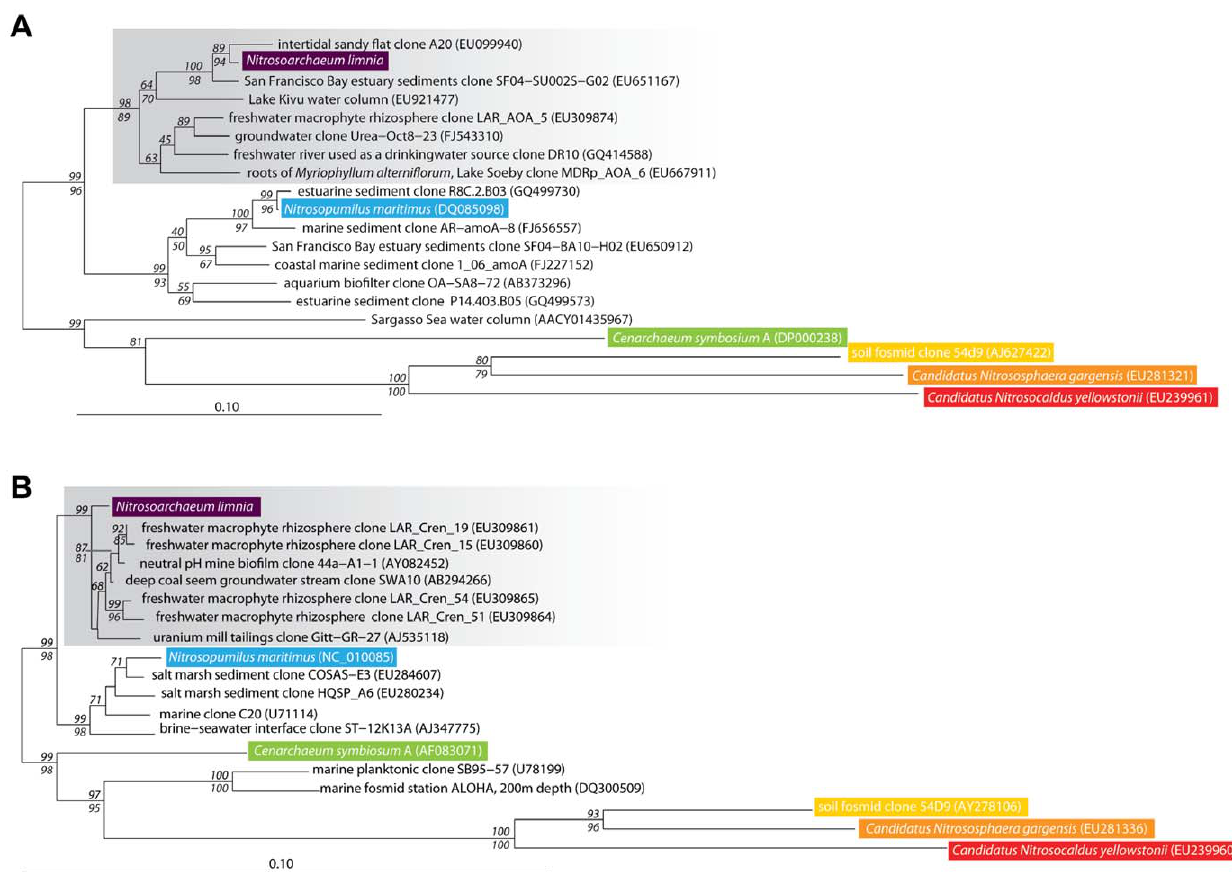
Figure 1. Phylogeny of Ammonia Oxidizing Archaea gene sequences. Neighbor-joining phylogenetic tree of (A) archaeal amoA gene sequences and (B) archaeal 16S rRNA gene sequences. Grey boxes highlight the putative low-salinity group. Significant bootstrap values ( $ 50) from 1000 replicates are shown in italics at branch nodes. Neighbor-joining bootstrap values are above the line and parsimony values are below the line.